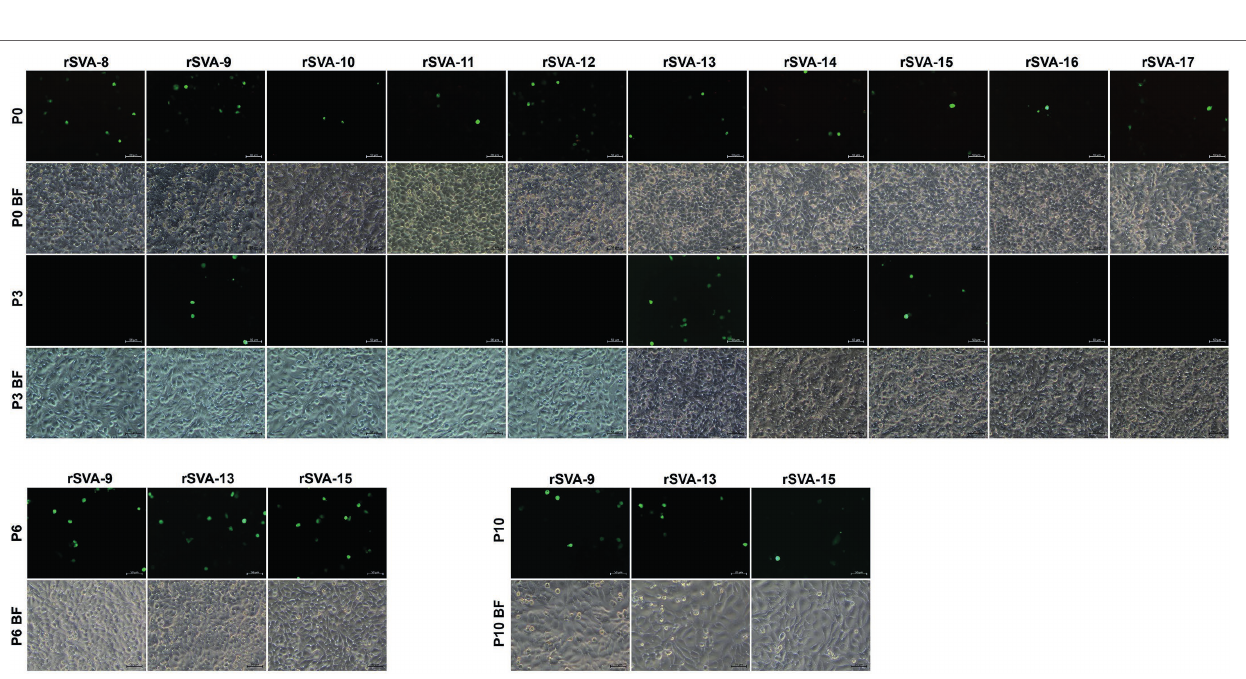
FIGURE 3 | Profiles of rSVA-0- to − 7-expressed eGFPs in BSR-T7/5 cells at P0, P6, and P10. Cell monolayers are separately transfected with cD-0 to − 7 and subjected to one freeze and thaw cycle at 72 hpt (P0) to collect supernatants for 10 serial passages. BF, bright field.